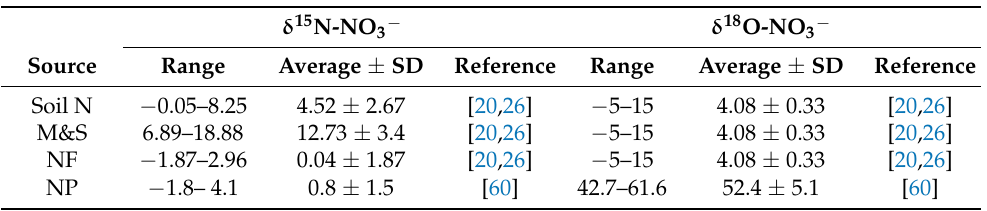
Table 2. The values of δ 15 N-NO 3 − and δ 18 O-NO 3 − values for potential sources of nitrate in the nearshore